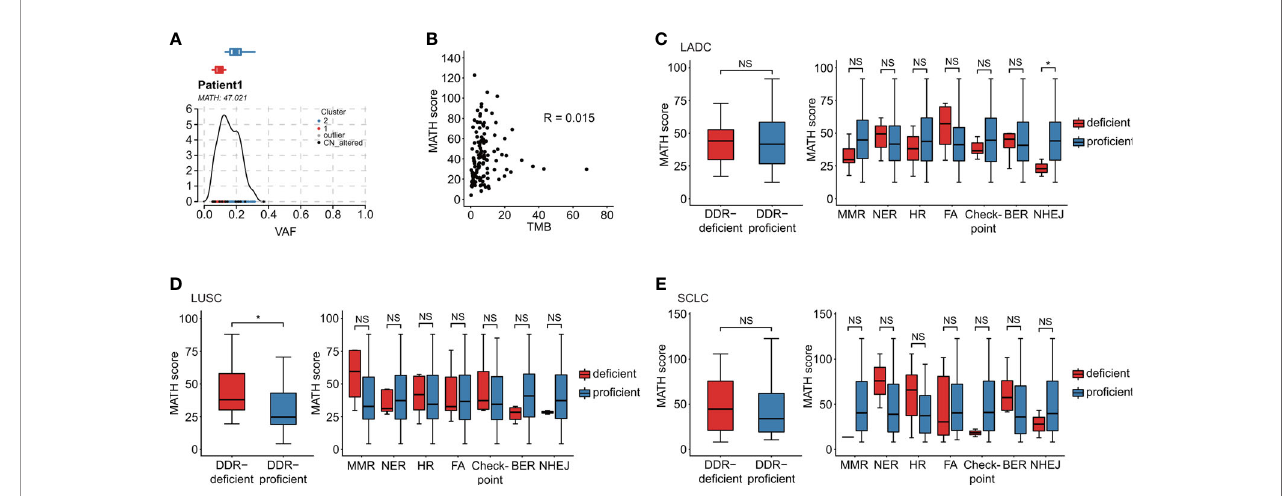
FIGURE 3 | Association of DDR gene alterations with ITH. (A) MATH score was calculated for the evaluation of ITH diversity. Take Patient 1 as an example. (B) TMB is a quanti fi cation of tumor mutations, and MATH score is a quanti fi cation of the ITH diversity. In our data, the patient ’ s Pearson correlation was only 0.015, which negated the correlation between TMB and ITH. (C – E) Relationship between MATH score and DDR alteration in distinct histological subtypes: LADC (n = 42), LUSC (n = 37), and SCLC (n = 36). (C) Relationship between MATH score and distinct alterations of DDR pathways in LADC subtype. (D) Relationship between MATH score and distinct alterations of DDR pathways in LUSC subtype. (E) Relationship between MATH score and distinct alterations of DDR pathways in SCLC subtype. Wilcoxon rank-sum test was utilized to study the relationship of DDR gene alterations with ITH. * p < 0.05. The "NS" referred to "not signi fi cant". The “ checkpoint ” referred to “ cell cycle checkpoint ”